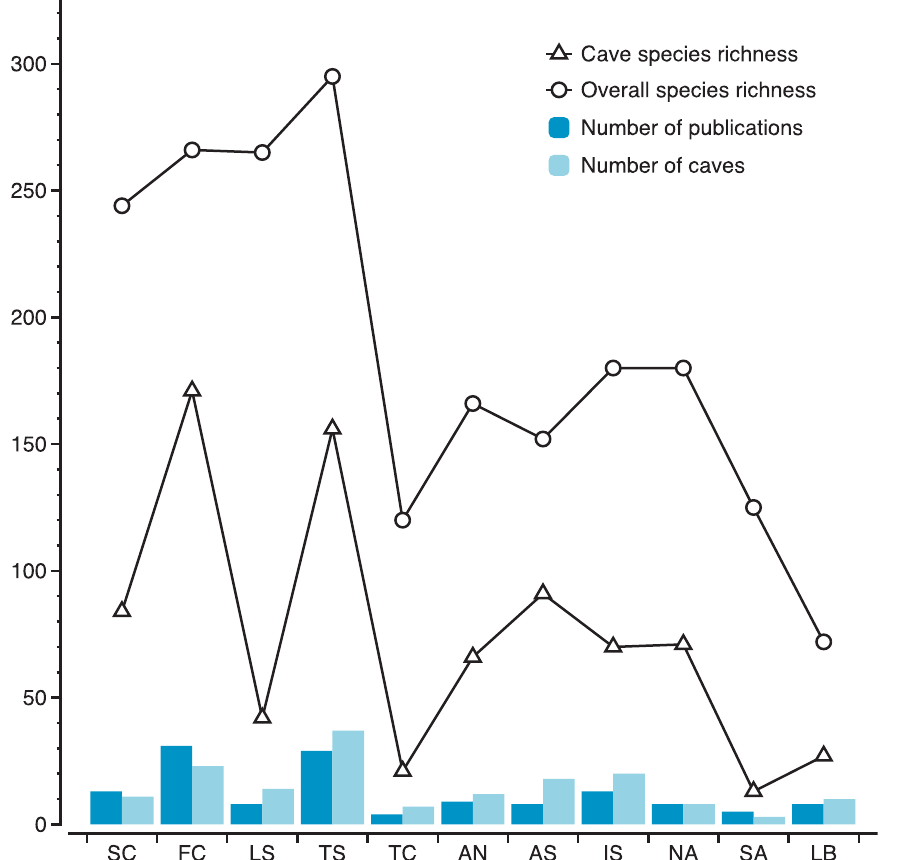
Figure 2. Research effort compared to sponge species richness in Mediterranean subareas. For abbreviations of Mediterranean areas see Methods.